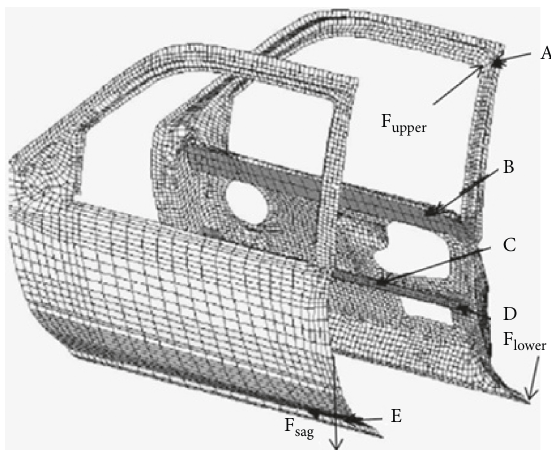
Figure 3: Finite element analysis of door